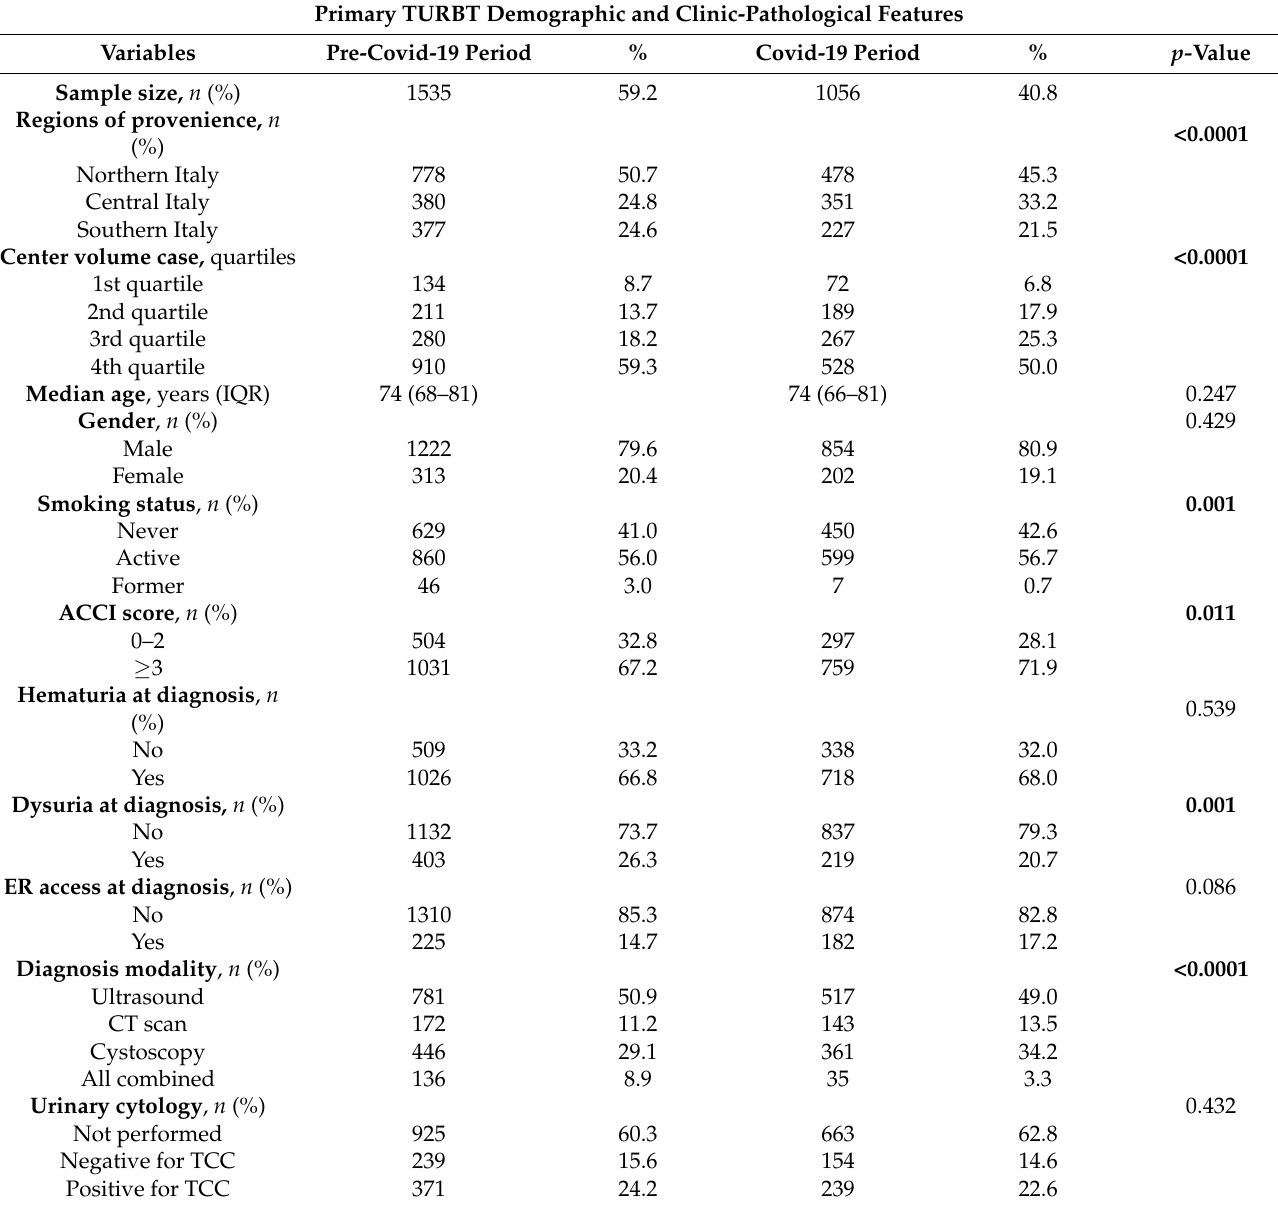
Table 1. Descriptive characteristics of the study cohort. In bold, value <